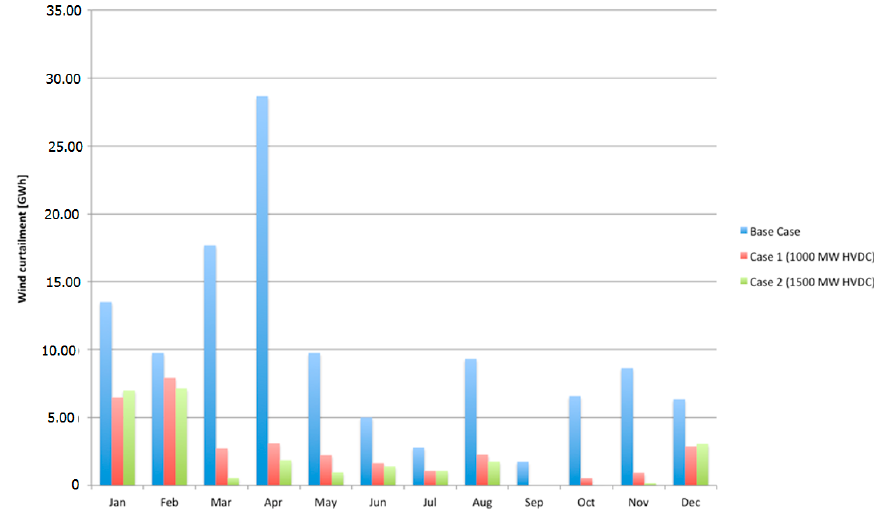
Figure 15. Comparison of wind curtailment levels resulting from the HVDC connection implementation.